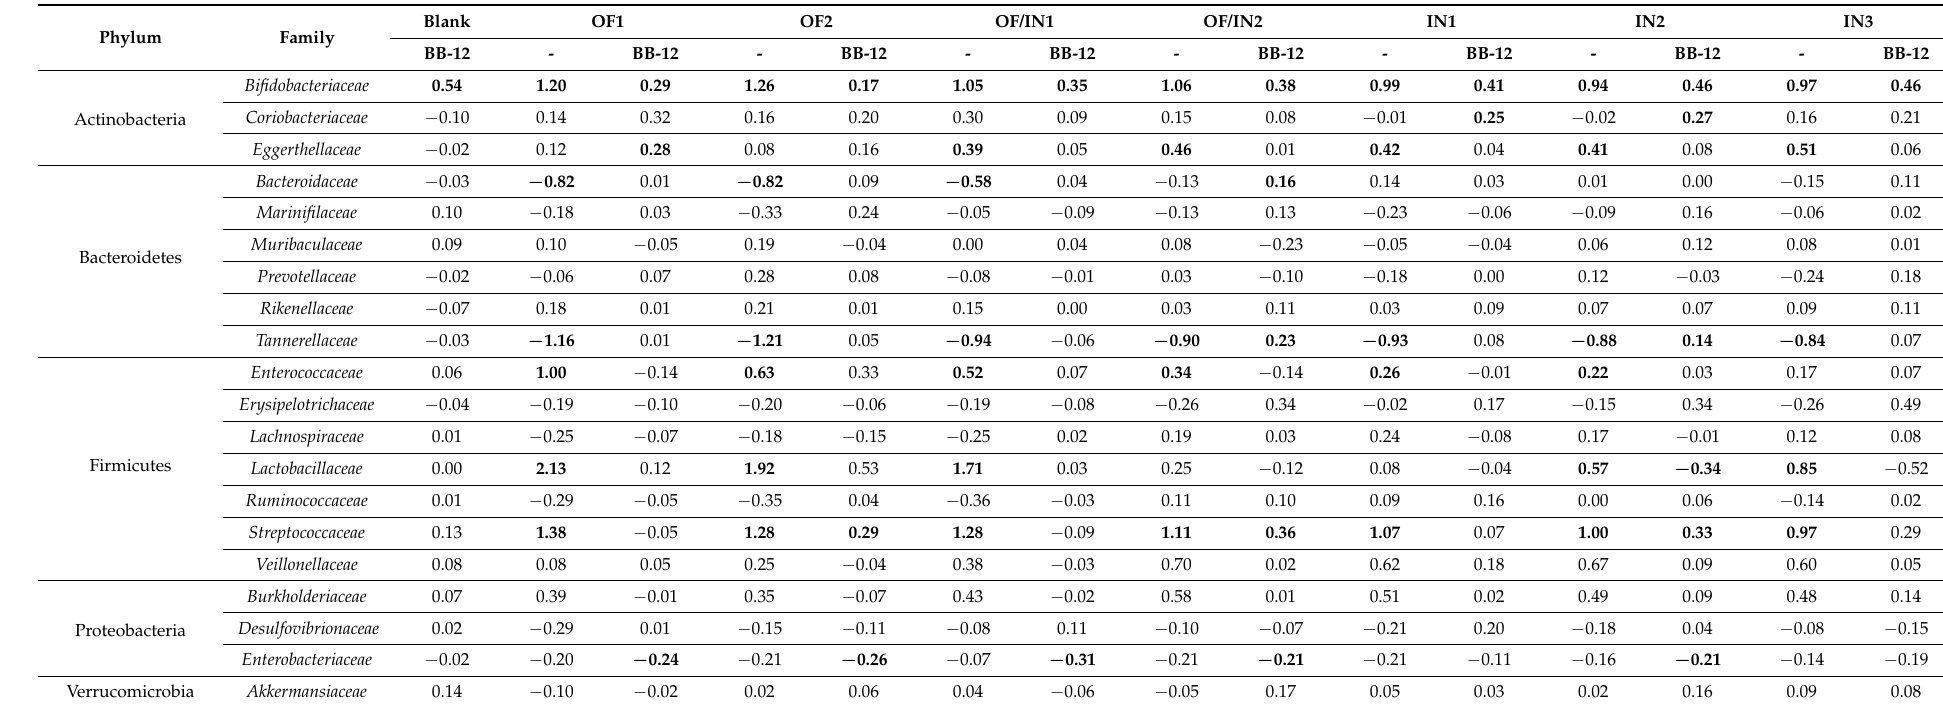
Table 4. Changes of microbial abundances at family level (log(cells/mL)) as detected via quantitative 16S − targeted Illumina sequencing at the end of the colonic incubation (48 h) upon dosing BB-12 and/or seven fructans with short (OF1, OF2), intermediate (OF/IN1, OF/IN2) and high degree of polymerization (IN1, IN2 and IN3) to the complex microbiota of three human donors (C, D and F). The values represent average differences versus the respective reference (for fructans, the reference was the untreated blank, while for conditions with BB-12 addition this was the respective condition where BB-12 was not dosed) at the end of the colonic incubation over the three donors. Significant changes are indicated in bold ( n = 9; 3 values for each of the 3